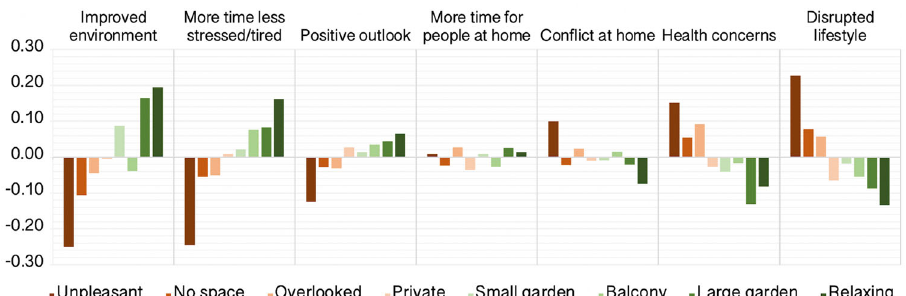
Fig. 8 Self-perceived pandemic impact by outside space at home. There were generally bene fi cial medium-scaled associations between quality of outside space people had at home and self-perception of the ways that they had been affected by the pandemic. Y axes = mean centred GLM parameter estimates when predicting component scores (SD units). Source data are provided as a Source data